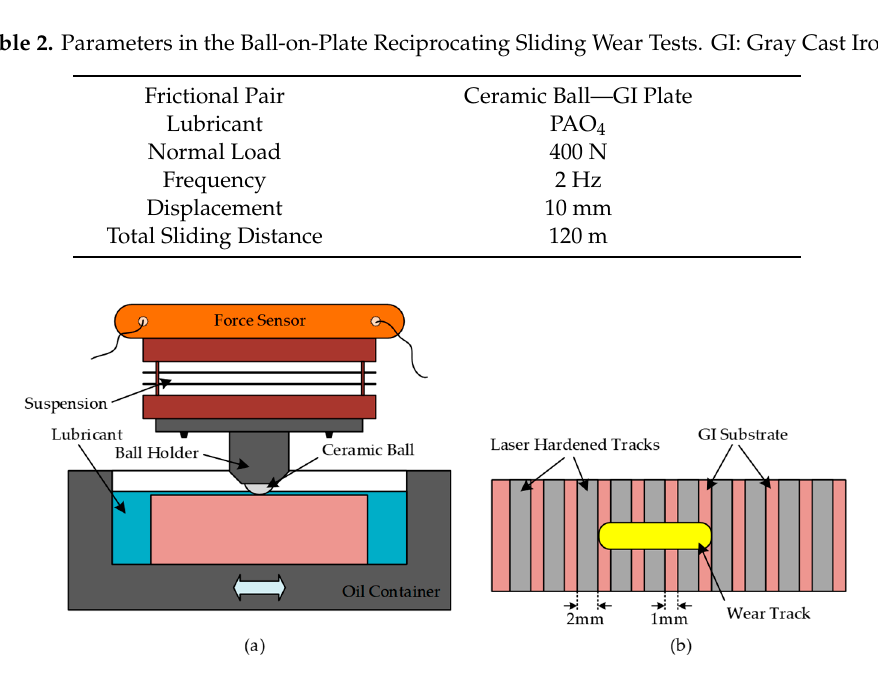
Figure 3. ( a ) Ball-on-Plate Reciprocating Sliding Wear Test Configuration; ( b ) Laser-Hardened Track Distribution.